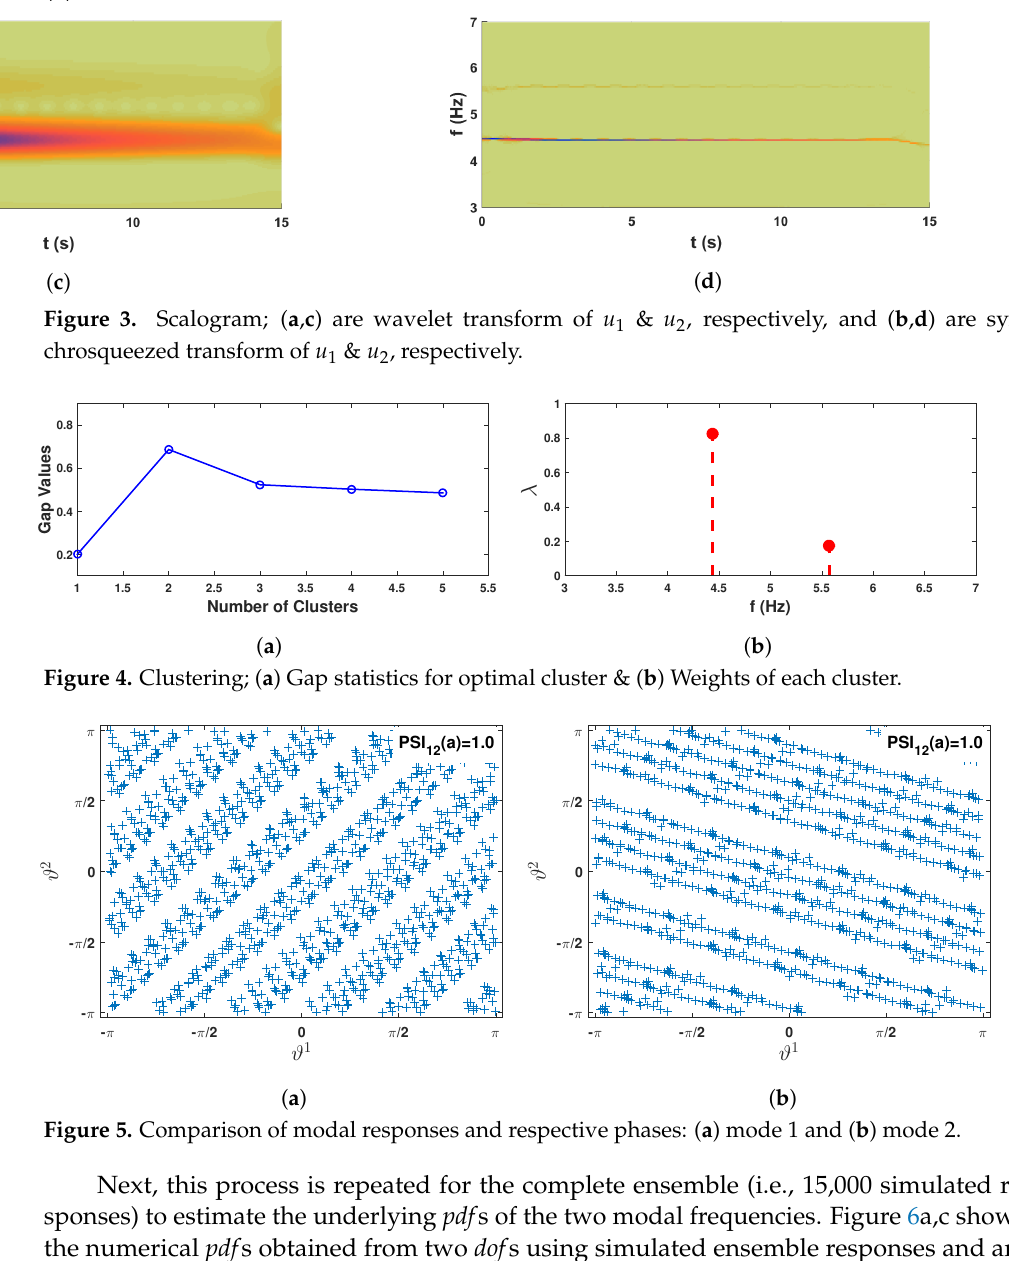
Figure 5. Comparison of modal responses and respective phases: ( a ) mode 1 and ( b ) mode 2. Next, this process is repeated for the complete ensemble (i.e., 15,000 simulated re- sponses) to estimate the underlying pdf s of the two modal frequencies. Figure 6a,c shows the numerical pdf s obtained from two dof s using simulated ensemble responses and are compared with their theoretical pdf s obtained using asymptotic integrals as described in Sections 2.1 and 2.2. Figure 6a shows a close match between the exact and estimated values of the pdf s associated with these modal frequencies obtained from the measurement in 1st channel. Corresponding cdf of error is shown in Figure 6b, where the vertical line repre- sents 5% error. This error estimate reveals that the reliability of the proposed